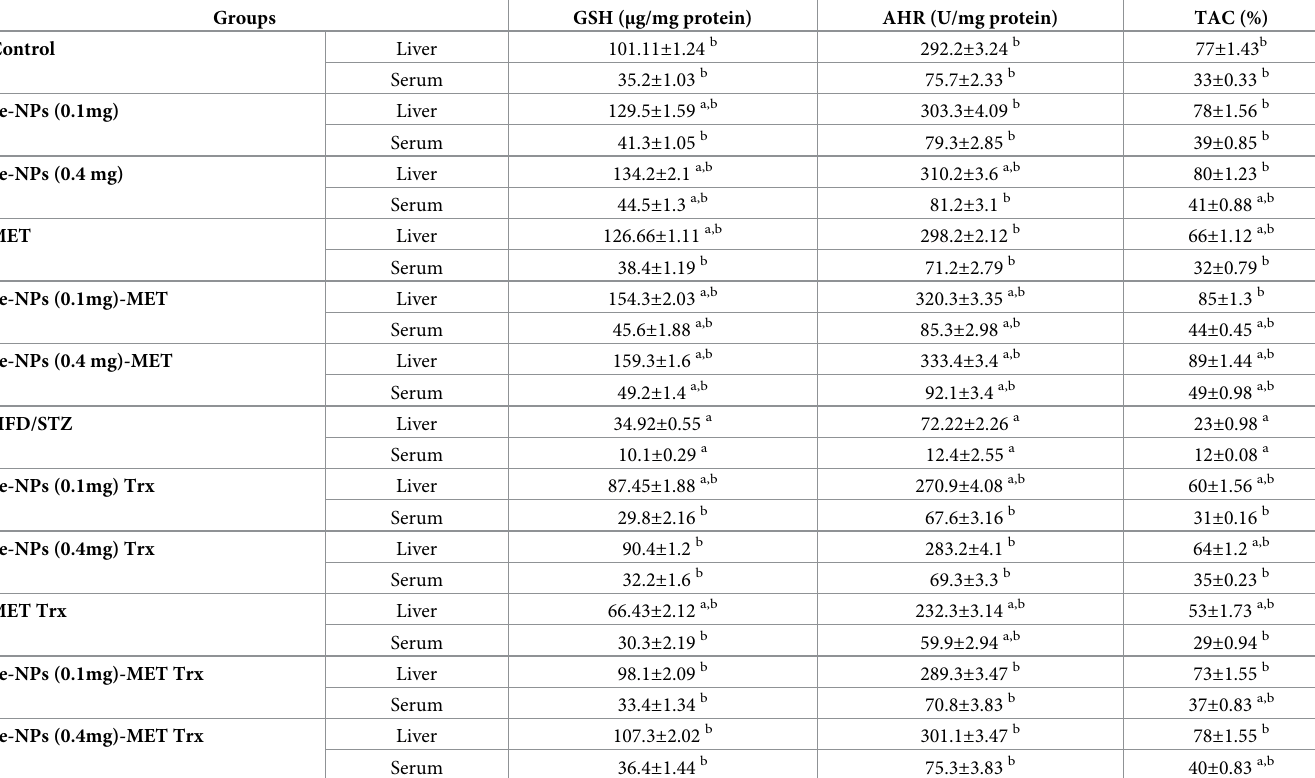
Table 8. Alteration of the level of non-enzymatic antioxidant proteins [GSH, AHR, and TAC] in serum and liver tissue of HFD/STZ-induced rats and after treat- ment with Se-NPs, MET monotherapy, and combined therapy.